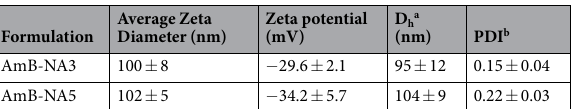
Table 1. Size and zeta potential of various AmB nano-formulations. a Volume-averaged hydrodynamic diameter (D h ) ± standard deviation. b Polydispersity Index ± standard